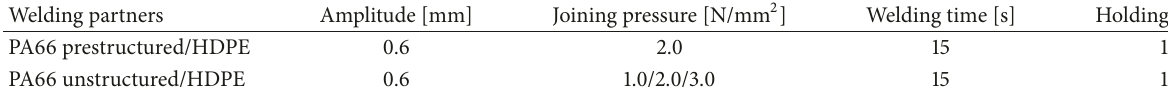
Table 3: Parameter settings of vibration welding process.